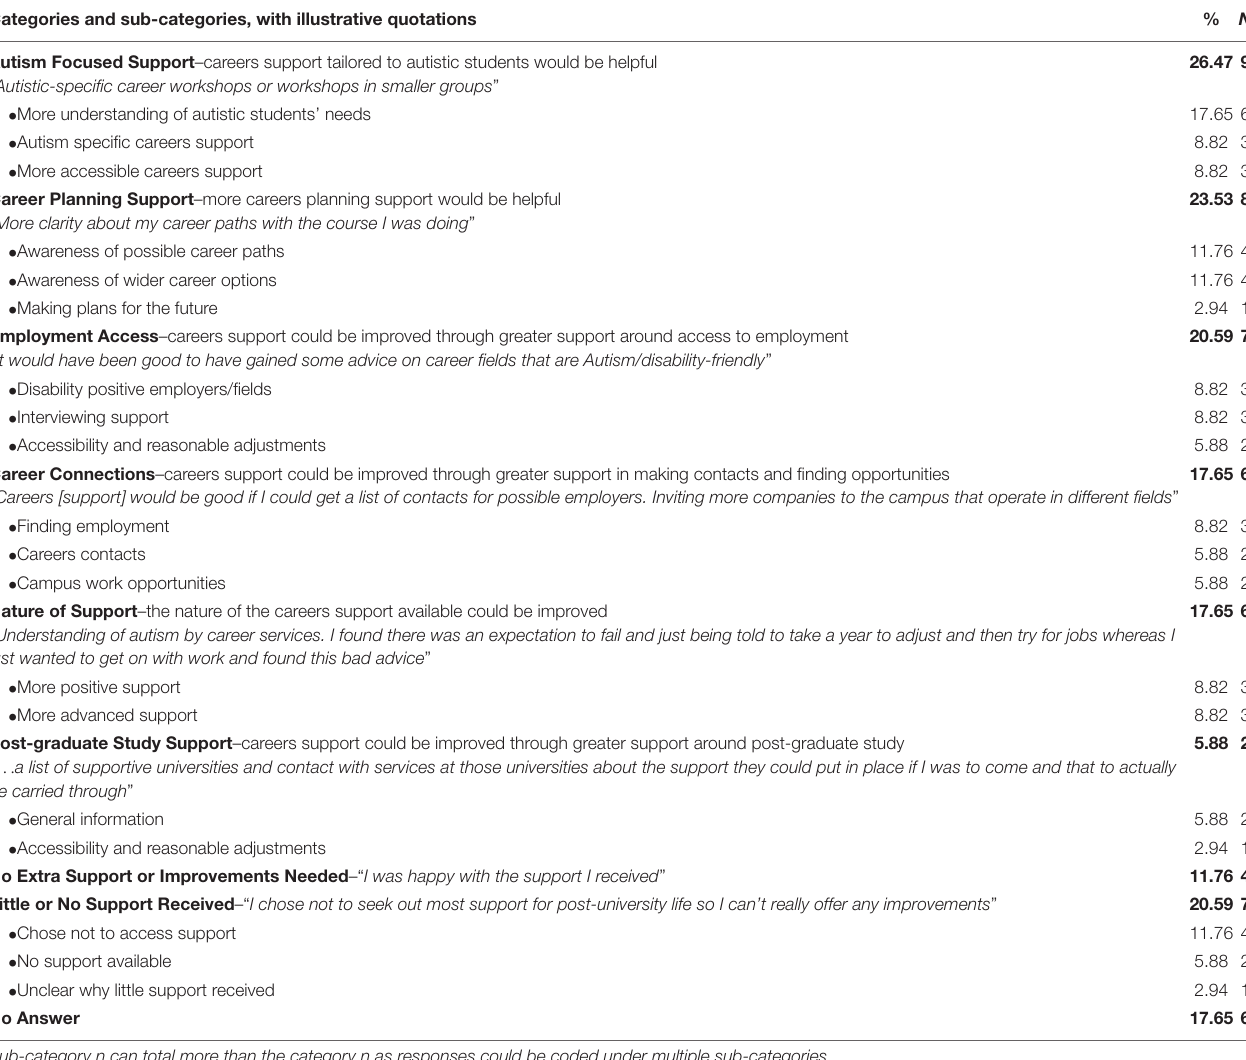
TABLE 5 | Content analysis of participants’ suggestions for career-related support additions or improvements, showing categories (in bold) and sub-categories (bullet pointed). Categories and sub-categories, with illustrative